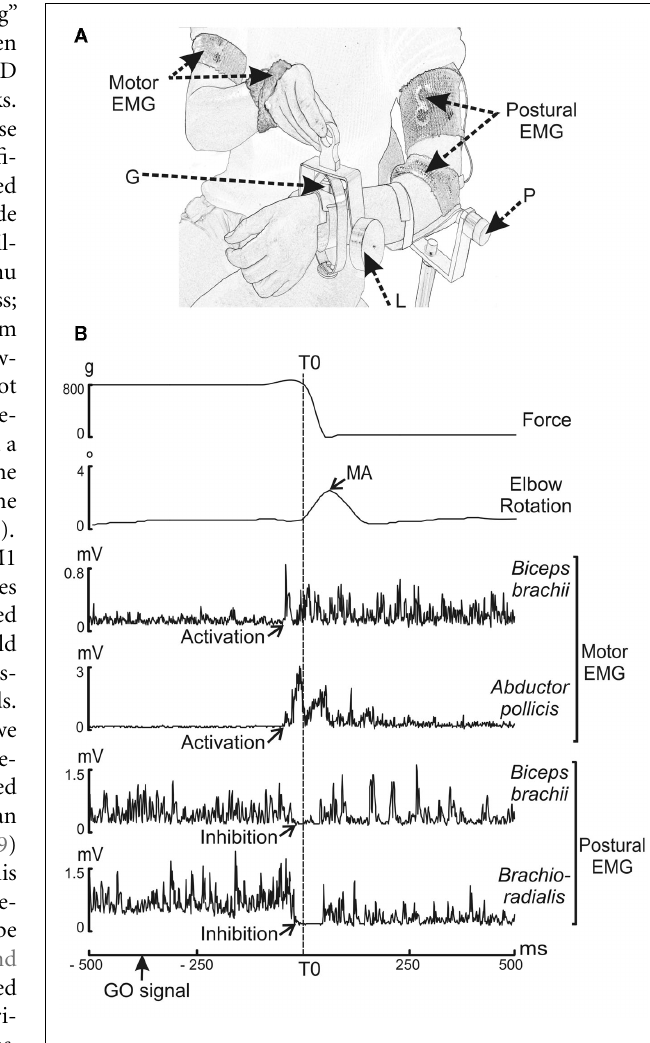
FIGURE 1 | (A,B) Experimental set-up and raw trial recording during voluntary unloading. (A) G: strain gage measuring the force exerted by the load. P: potentiometer measuring the elbow rotation. L: 800g-load. Motor EMG: EMG recording sites in the motor arm (biceps brachii and abductor pollicis brevis). Postural EMG: EMG recording sites in the postural arm (brachioradialis and biceps brachii). (B) Parameters recorded (from top to bottom) are: force, elbow rotation angle, rectified EMG of the biceps brachii and abductor pollicis brevis on the motor arm, and of the biceps brachii and brachioradialis on the postural forearm.The decrease in force indicated the onset of unloading (vertical dashed line), which was used as a reference time (T0).The maximum angular amplitude (MA) of the upward movement of the postural forearm was measured after unloading.The muscular activity (activations for the motor arm and inhibitions for the postural arm) occurred